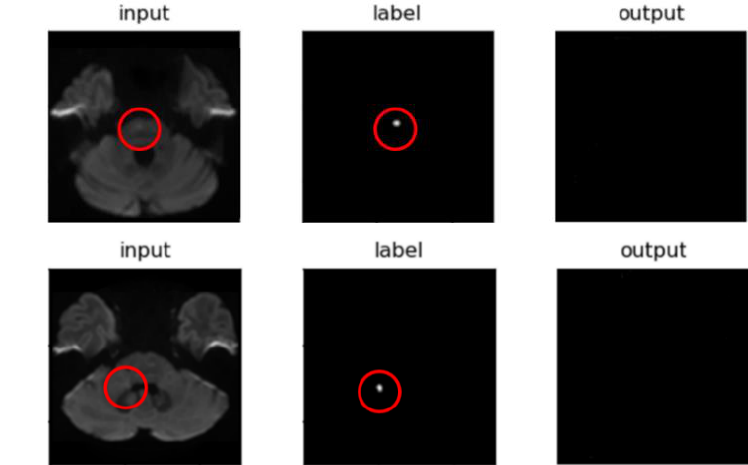
Figure 5. Example images for small-sized AIS: ( a ) Internal validation and ( b ) External validation.